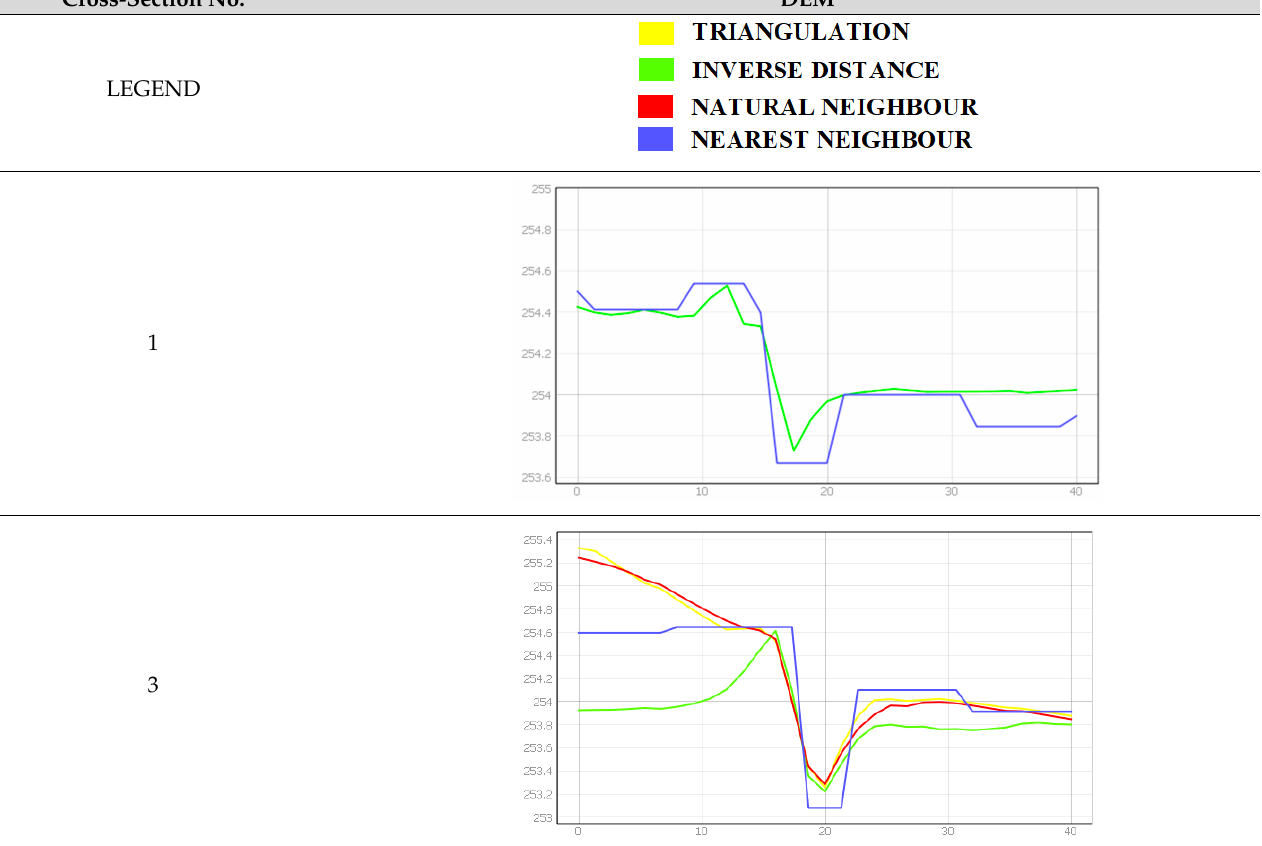
Table 3. Cross-sections generated on the DEM created from GNSS RTN survey; source: own elaboration. Cross-Section No.